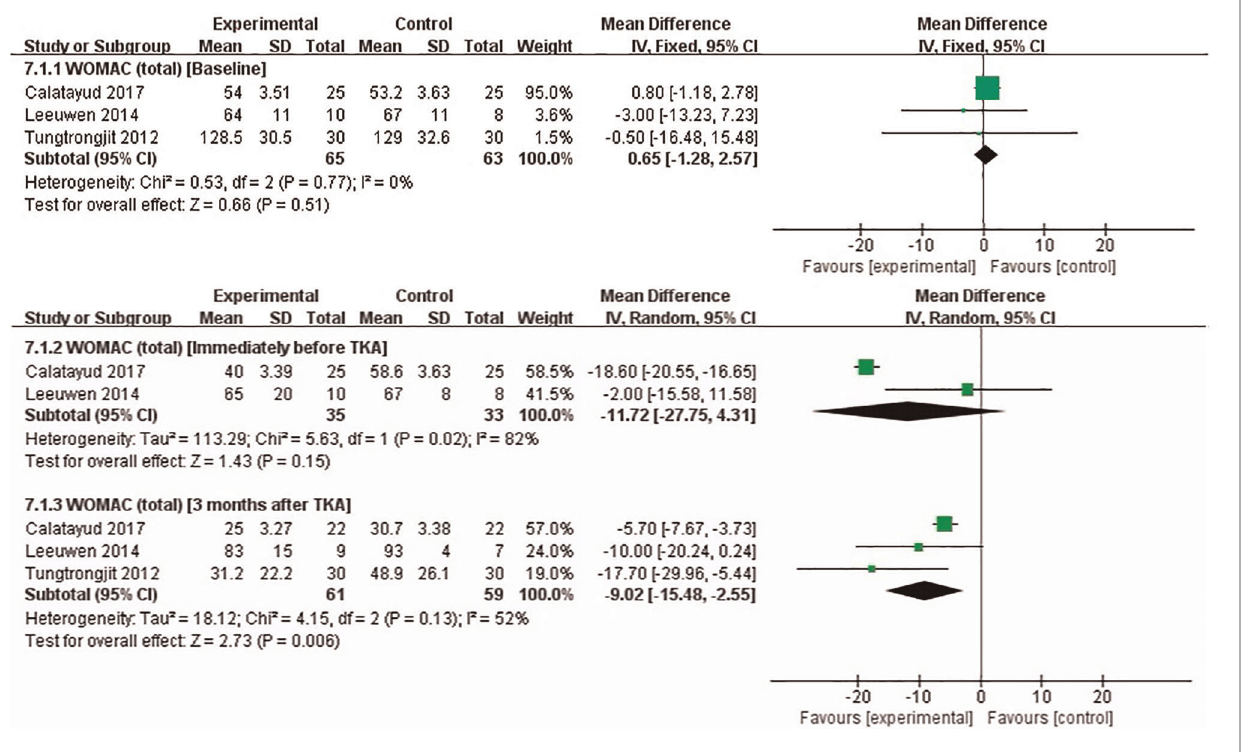
FIGURE 9 | Meta-analysis on WOMAC